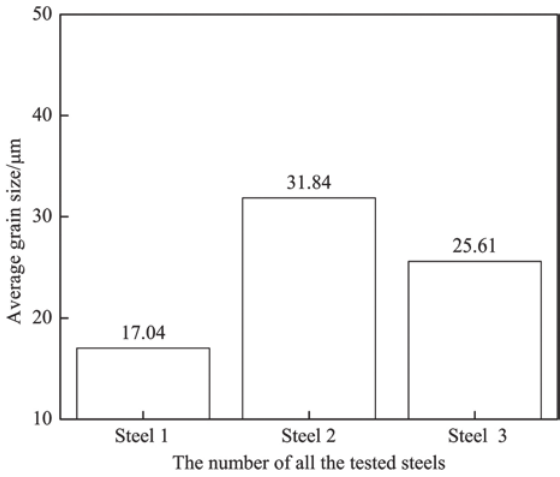
Fig. 6: Average grain size of annealed cold-rolled steel